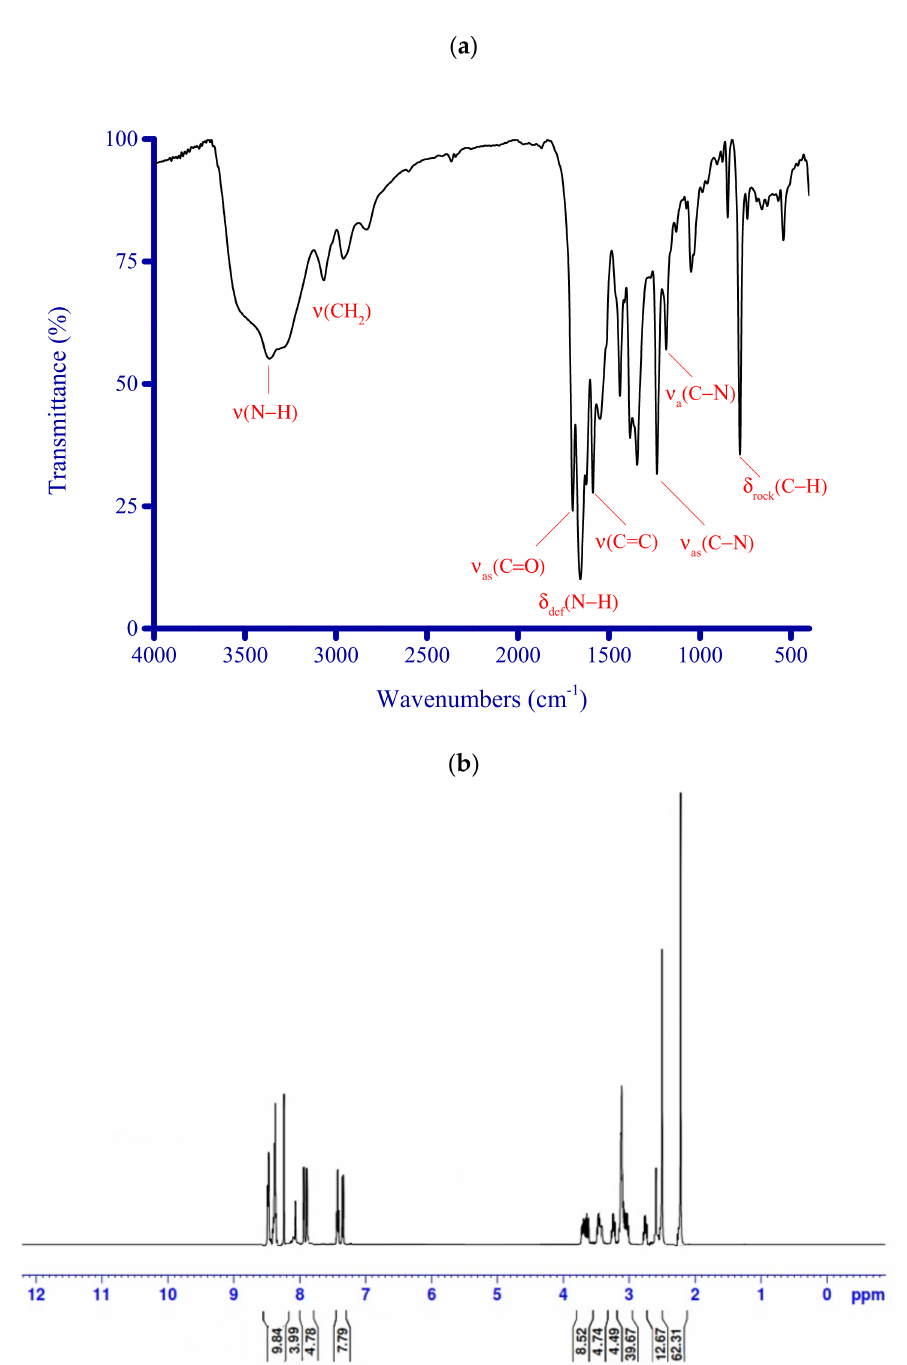
Figure 3. ( a ) IR and ( b ) 1 H NMR spectra of the synthesized